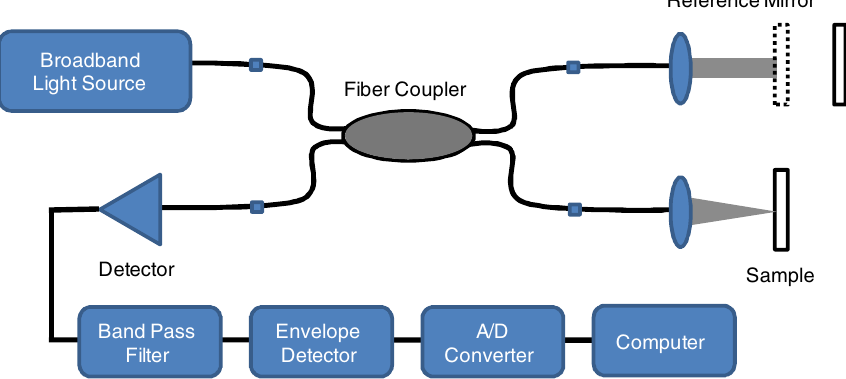
Fig. 1. Schematic representation of a fiber based time domain OCT system. The Michelson interferometer is implemented using a fiber-optic coupler. Light from the low-coherence source is split and sent to a sample arm with a beam delivery instrument and a reference arm with an optical path-length scanner. Reflected light from both arms are combined and is detected with a photodiode in the output of the